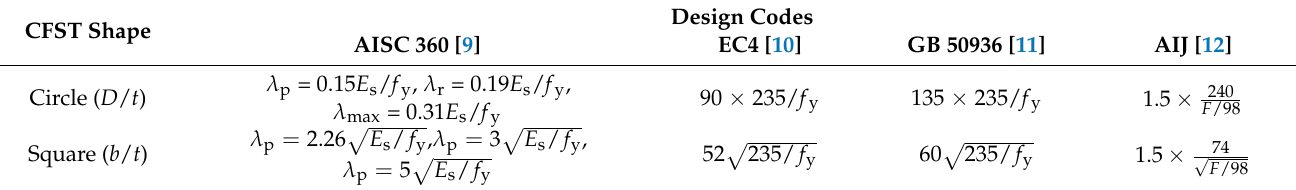
Table 1. The limitations of width-to-thickness ratio in current design codes.